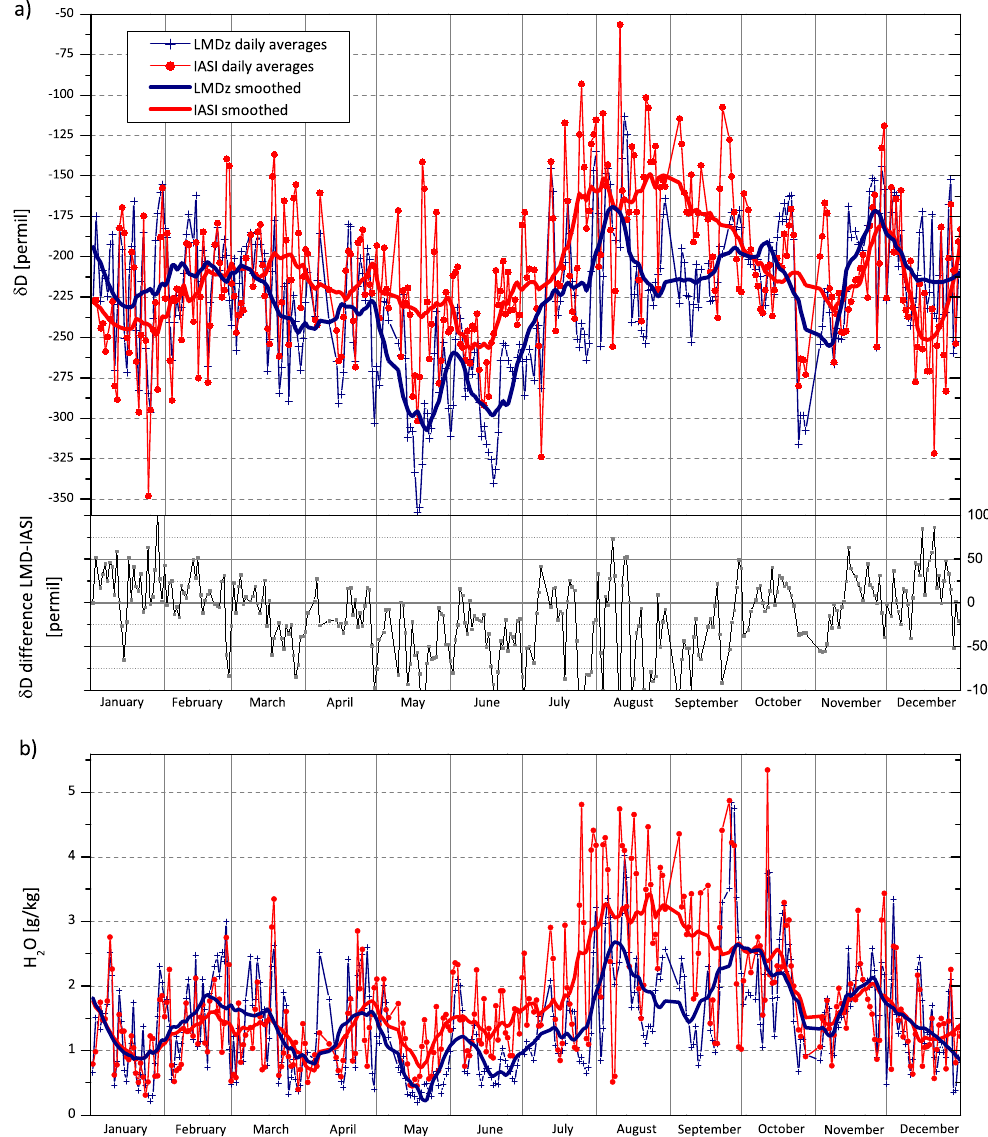
Fig. 8. Same as Fig. 7 but for the Iza˜na